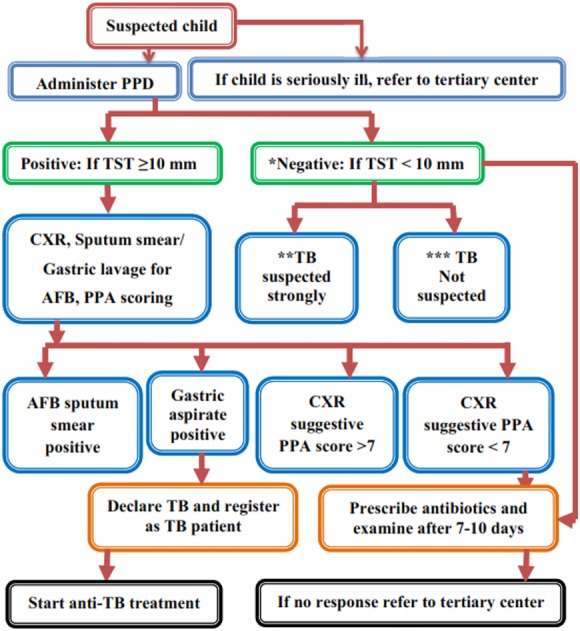
NTP flow chart for assessment of a child with suspected TB.*, Negative TST does not rule out TB, evaluate further if strongly suspected. **, prolong illness like cough, fever, weight loss, abdominal mass, lymphadenopathy and history of contact with TB case in family. ***, Absence of above.